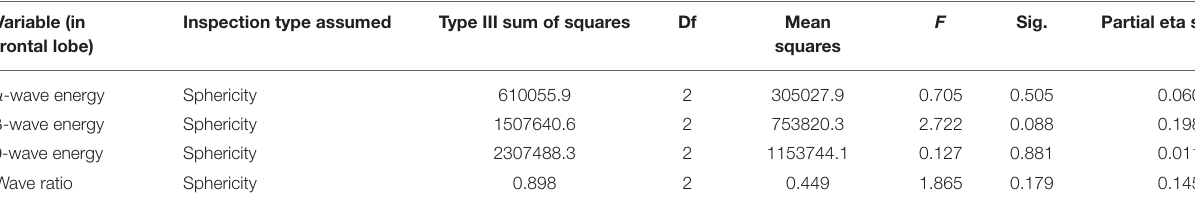
TABLE 3 | Tests of within-subject effects. Variable (in frontal lobe)